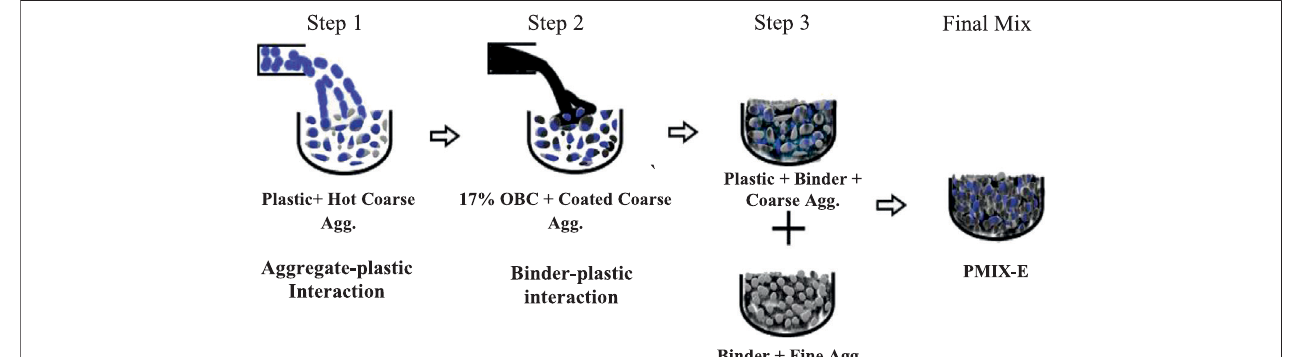
FIGURE 2 | Enhanced dry process method for PMIX-E